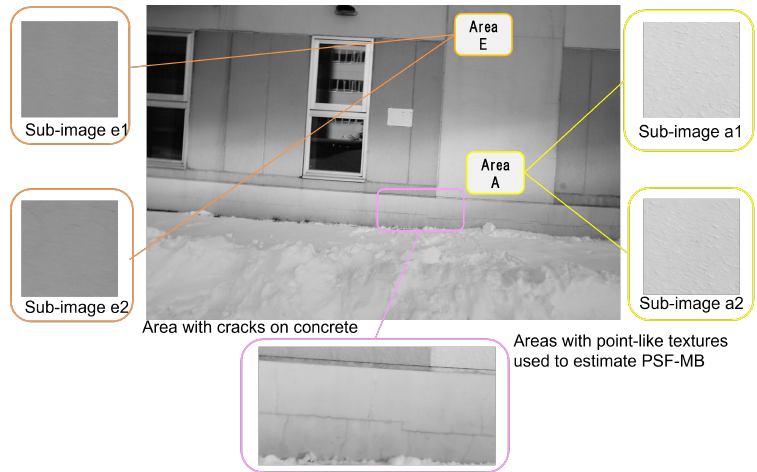
Figure 12. Blurred image captured by a shaked camera.